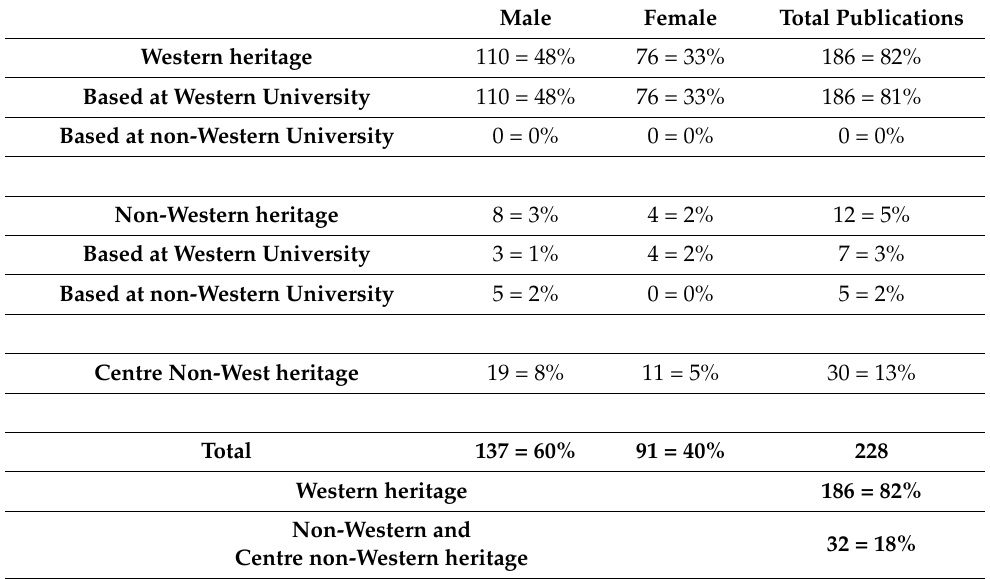
Table A7. Media, war, and